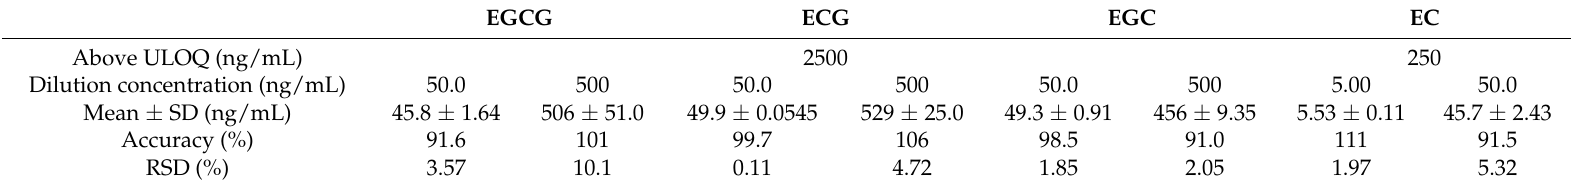
Table 4. Dilution integrity at a concentration five-fold higher than the upper limit of the quantification